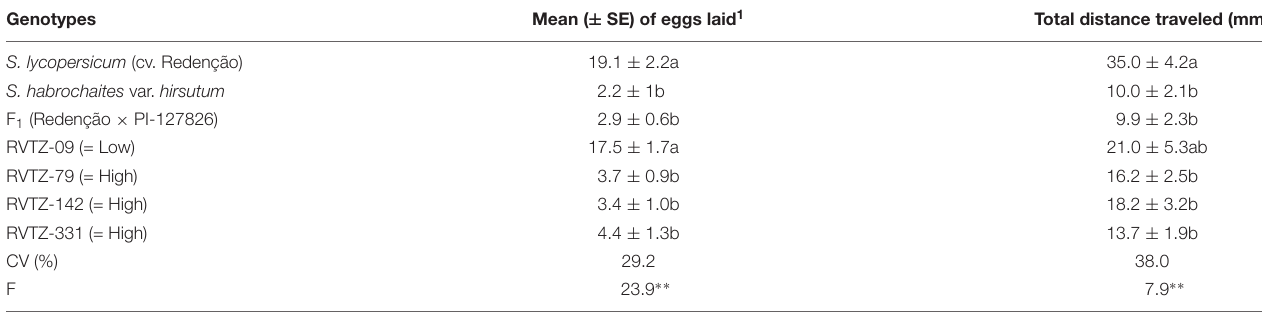
FIGURE 1 | Leaflet surface of S. habrochaites var. hirsutum (A) and S. lycopersicum cv. Redenção (B) obtained in a scanning electron microscope (SEM) showing different trichome types. Type IV (Gl-IV) and VI (Gl-VI) glandular trichomes (A) , and type VIII (NGI-VIII) non-glandular trichome (B) according to Luckwill (1943) and Toscano et al. (2001) classification. TABLE 2 | Mean number ( ± SE) of eggs laid on leaf disks from different tomato genotypes during first 24 h of the no-choice test, and total distance traveled (mm) by the mites on the abaxial leaflet surface of the genotypes after 60 min. Genotypes Mean ( ± SE) of eggs laid